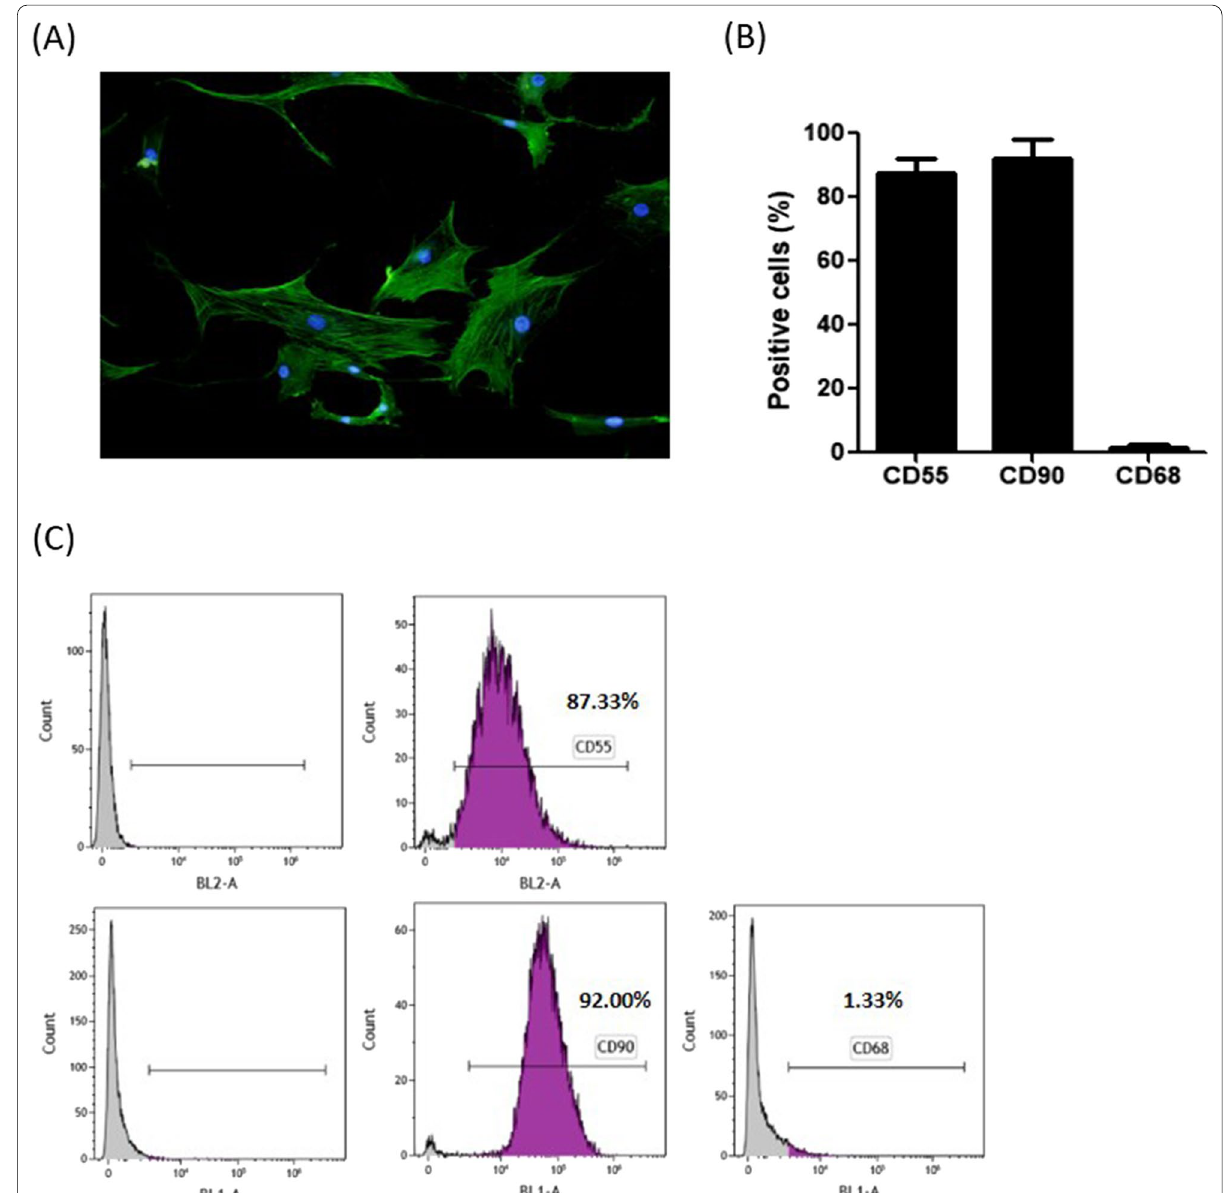
Fig. 1 Characterization of FLS cultures. A Representative image of FLS morphology labeled with Phalloidin for actin filamentous, F-actin (green), and DAPI for nuclei (blue). B Percentage of positive cells for CD55, CD90 (both FLS markers), and CD68 (macrophage marker). (C) Representative of flow cytometry analysis for CD55, CD90, and CD68. Data are expressed as mean ±